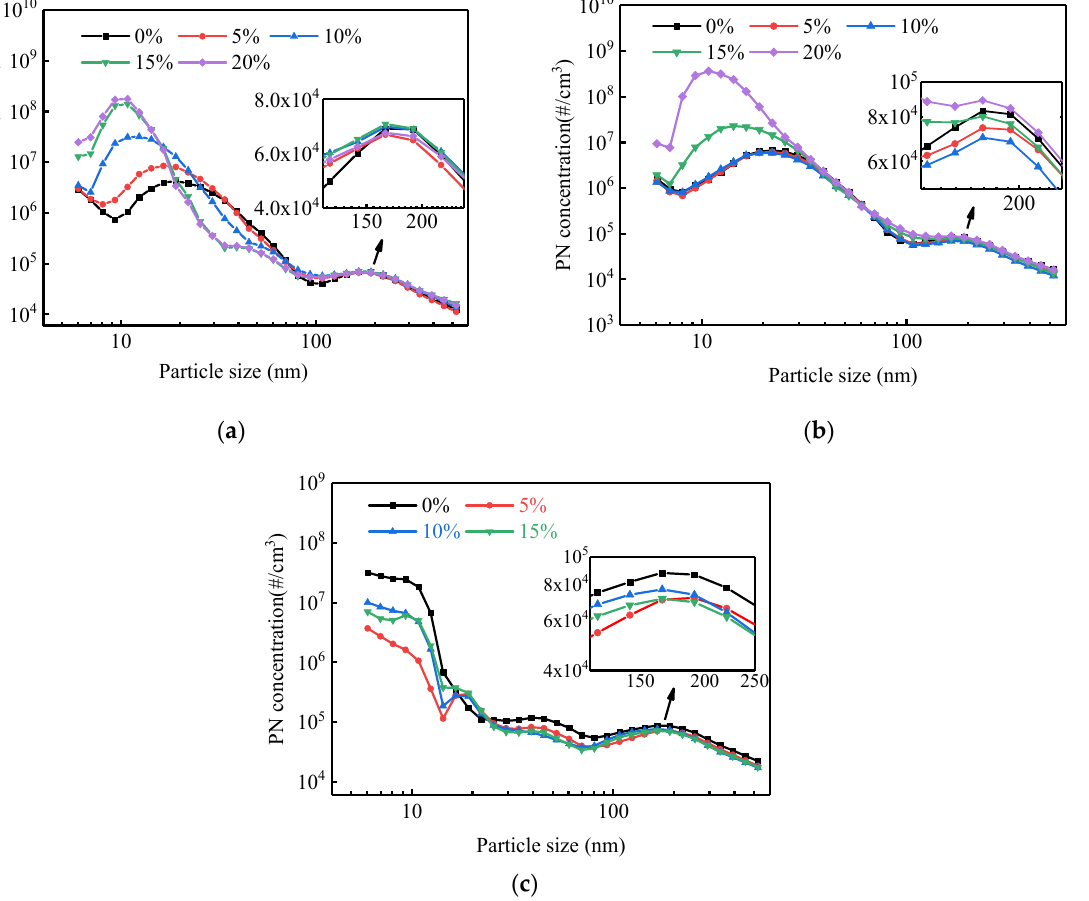
Figure 5. Distribution characteristics of particle size with EGR rate. ( a ) 2000 r/min 10 bar; ( b ) 2000 r/min 15 bar; ( c ) 4000 r/min 10 bar.